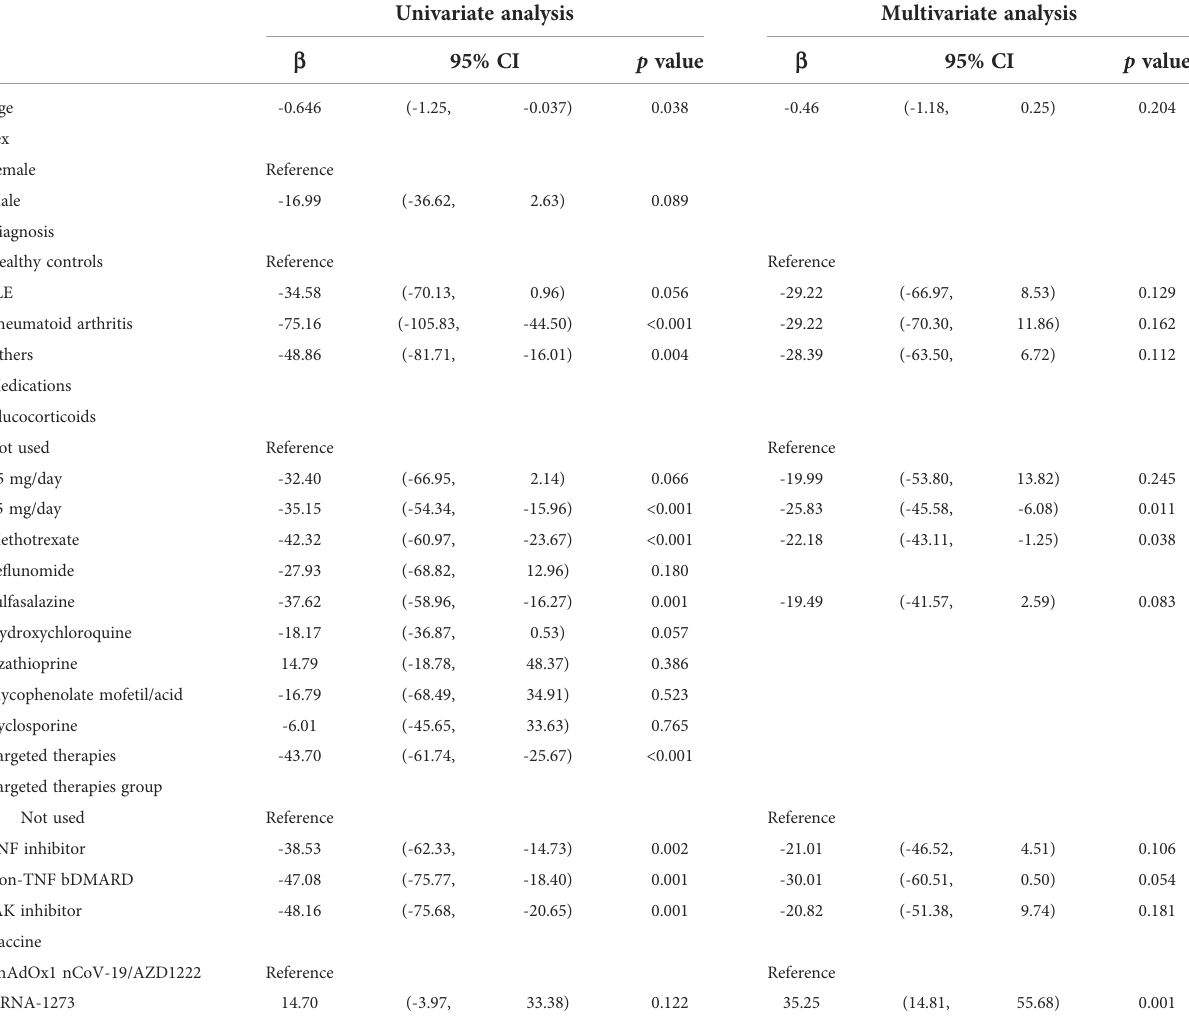
TABLE 2 Multivariate analysis of anti-SARS-CoV-2 IgG level in patients with rheumatic diseases following the fi rst dose of COVID-19 vaccines. Univariate